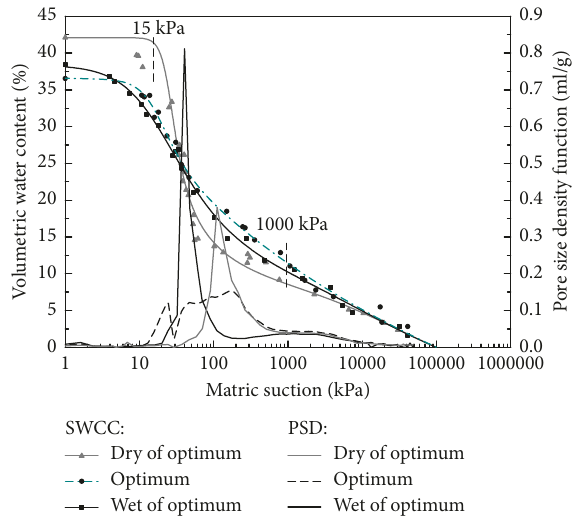
Figure 15: Comparison of the SWCCs and PSDs of loess com- pacted at different initial water